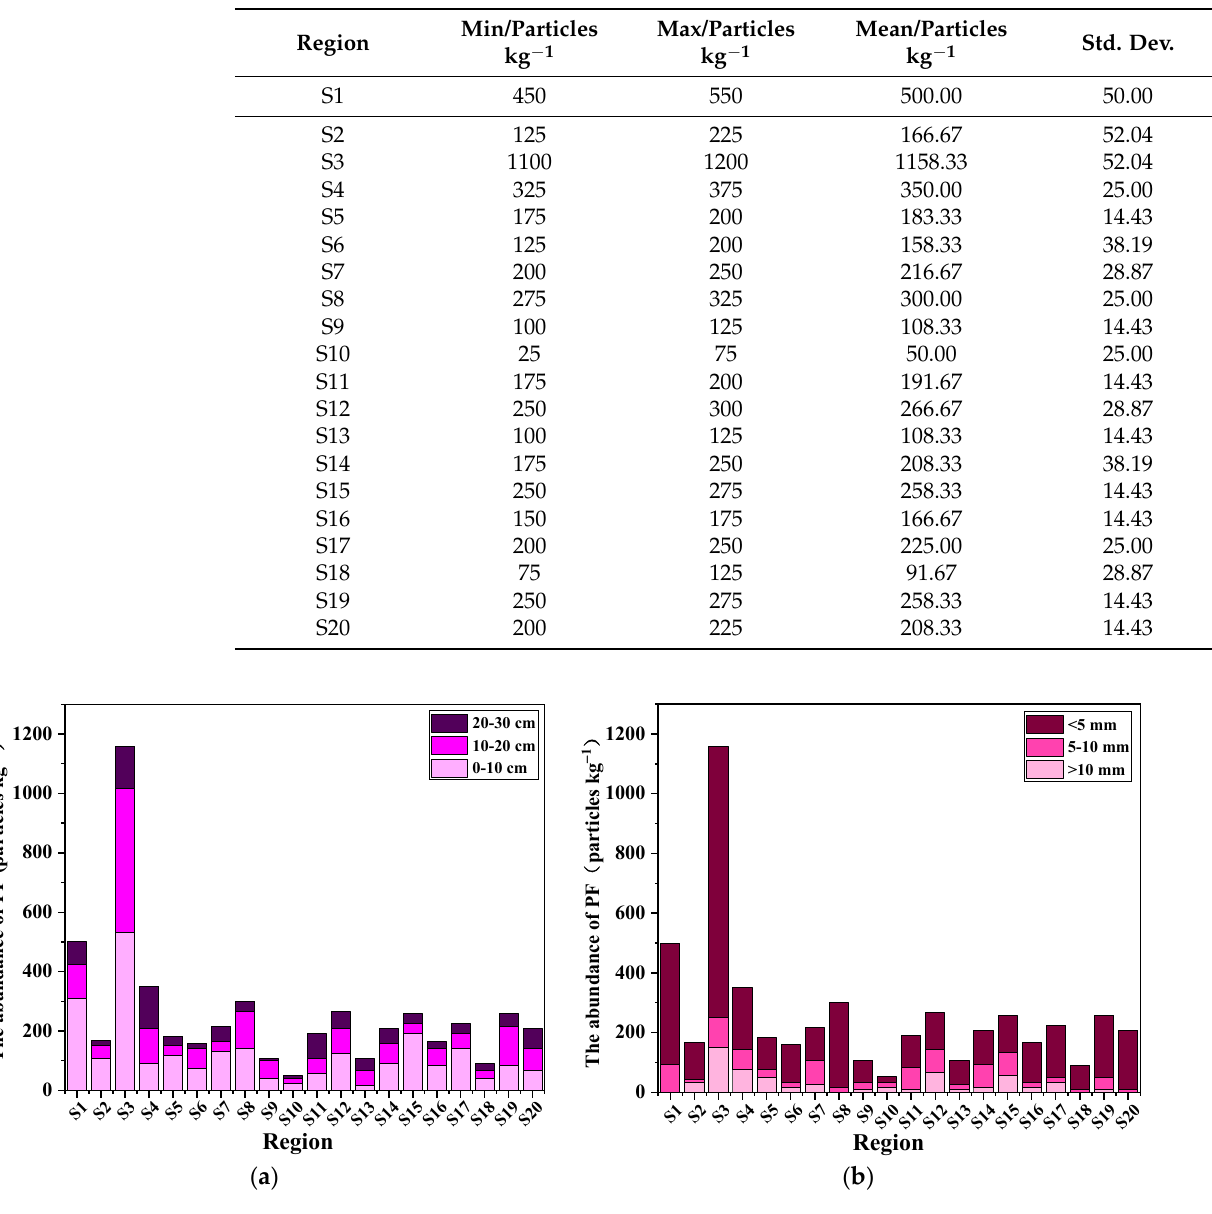
Figure 2. The abundance and distribution of PF in the different regions of Sichuan Province. ( a ) Residual amount and distribution of PF in the different soil layers; ( b ) Size distribution of PF in the soil samples from different areas of Sichuan Province.